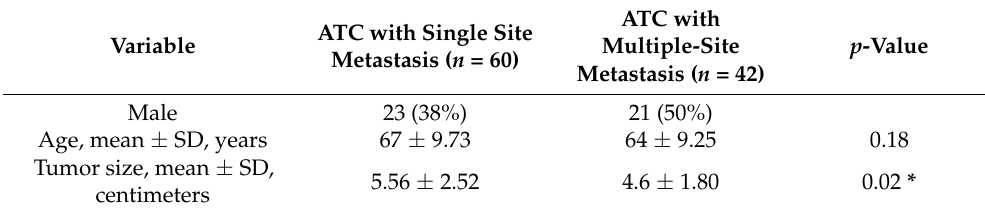
Sixty patients (59%) had single-site metastasis, and 42 patients (41%) had multiple- site metastases. There were no statistically significant differences between these two groups in T-, N-, and survival rates, except for tumor size (5.56 ± 2.25 cm in single-site metastasis, 4.6 ± 1.80 cm in multiple-site metastasis; 95% CI, 0.19–0.1.89; p = 0.02) (Table 5 and Figure 1C). Table 5. Clinical features of patients with ATC with multiple metastasis. ATC with Single Variable